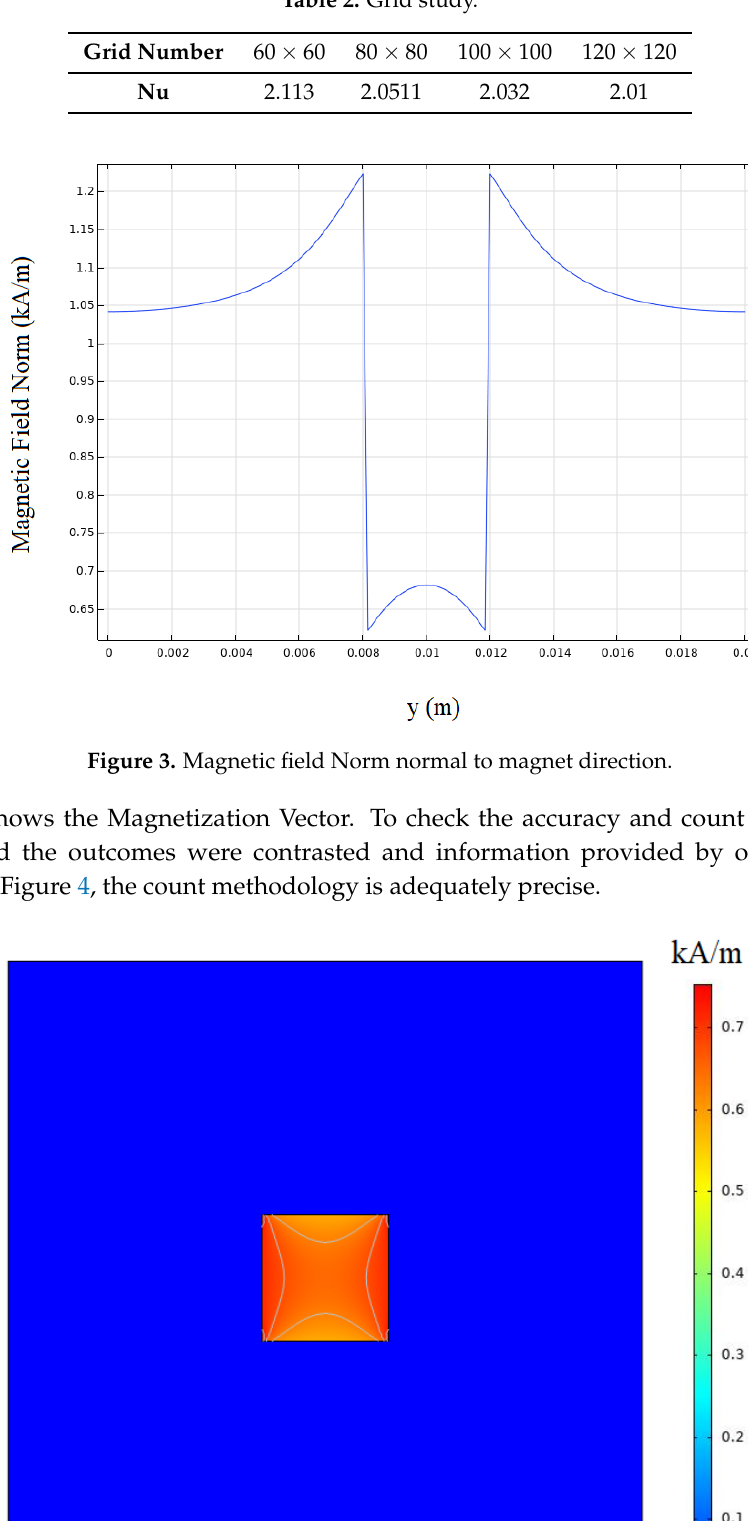
Table 2. Grid study.